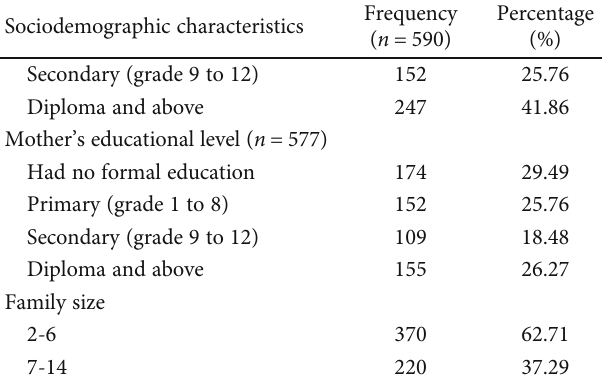
Table 1: Sociodemographic characteristic of adolescent students and their parents in Ambo town, Oromia region, Ethiopia,